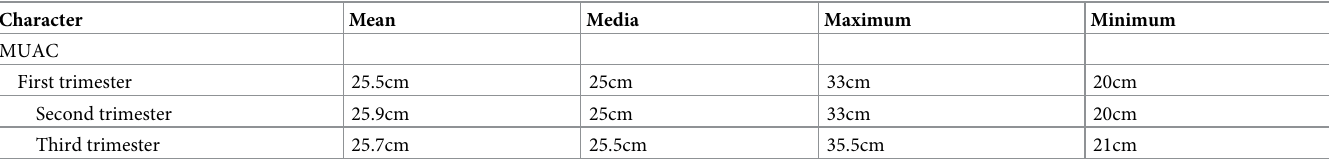
Table 3. The MUAC feature of pregnant women attending ANC at Debre Markos Referral Hospital at different trimesters.